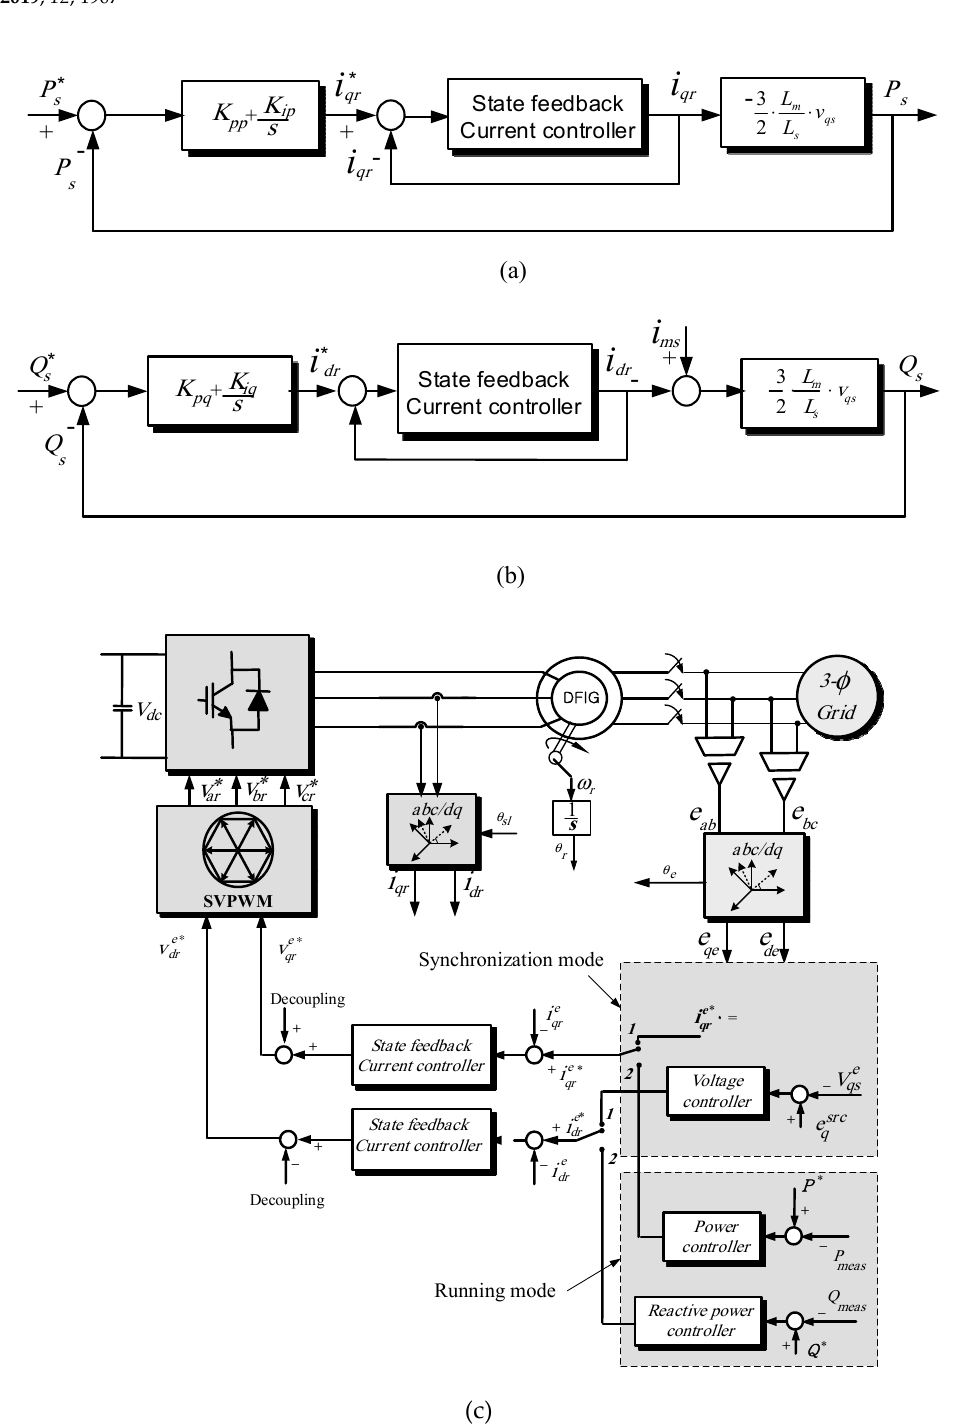
Figure 11. DFIG rotor-side ( a ) active power control, ( b ) reactive power control, and ( c ) the total control block diagram of the DFIG.